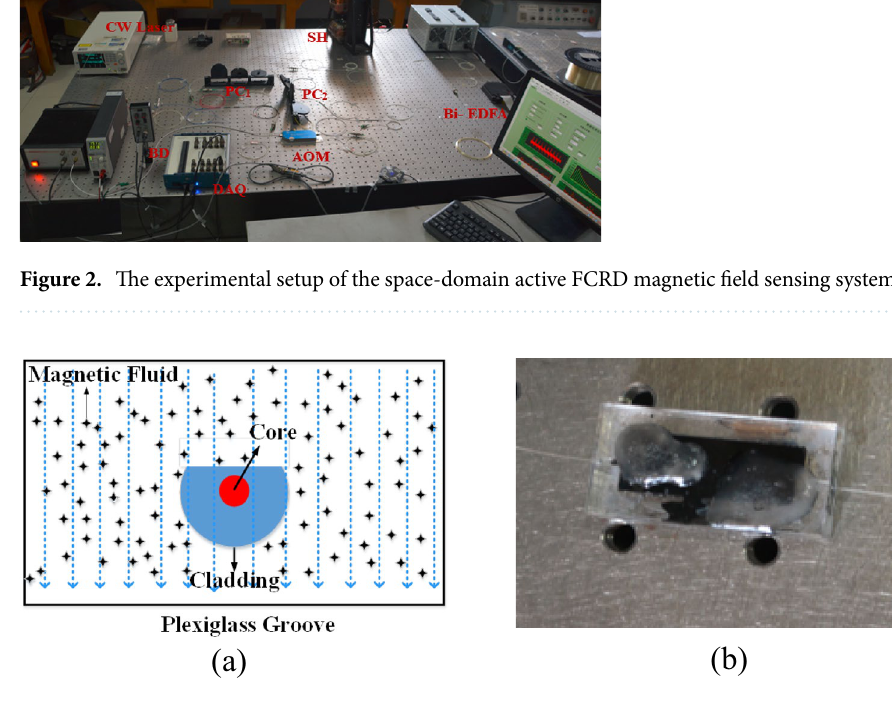
Figure 3. (a) Schematic diagram of magnetic field sensor head; (b) physical view of the magnetic field sensor